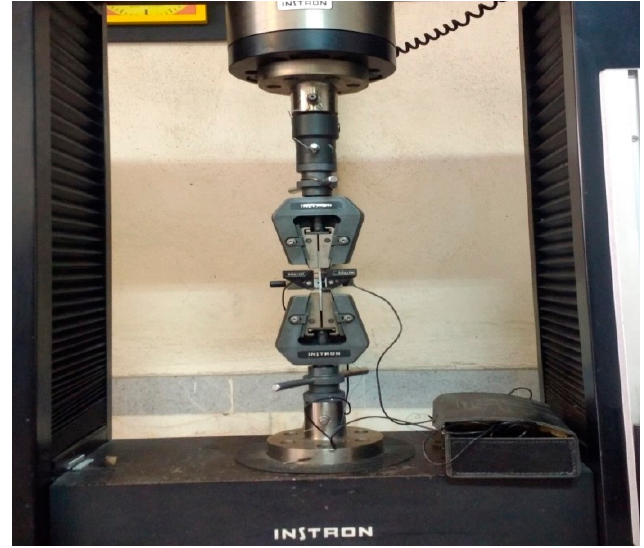
Figure 1. Uniaxial tensile test.